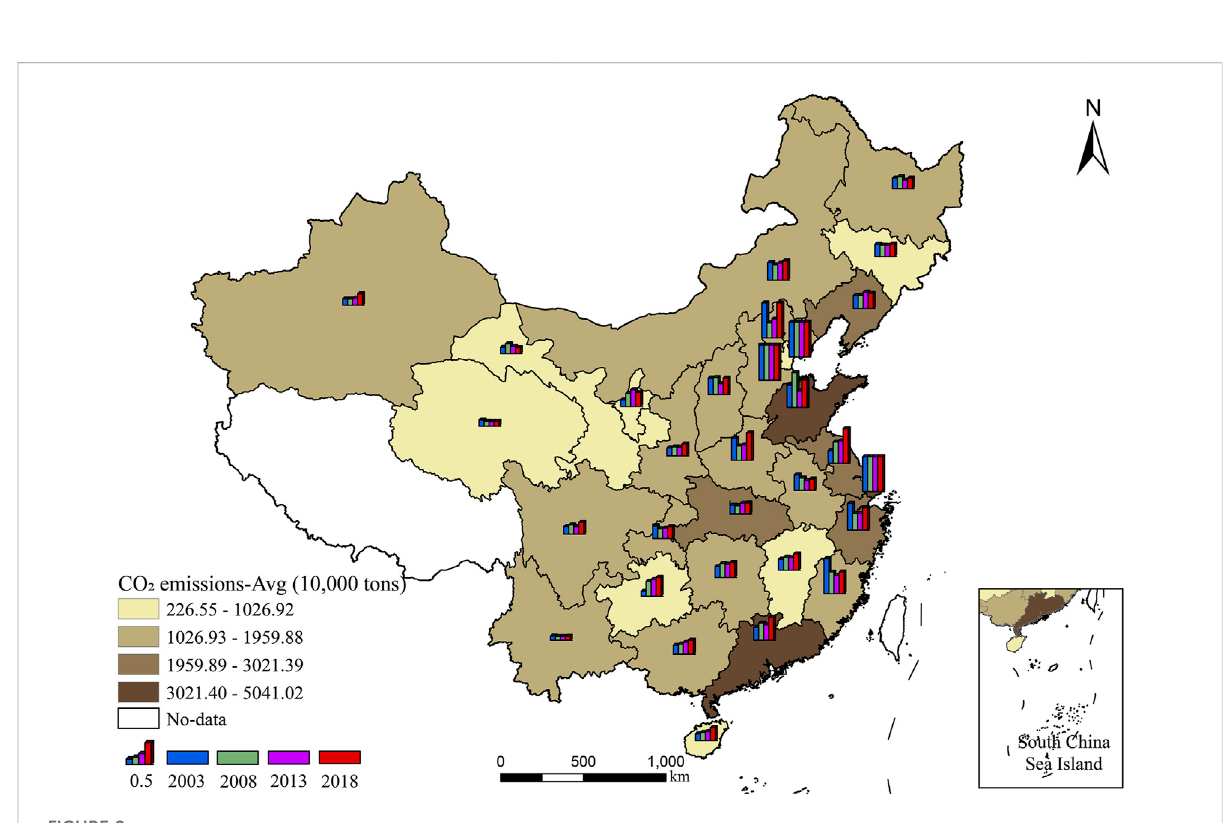
Frontiers in Earth